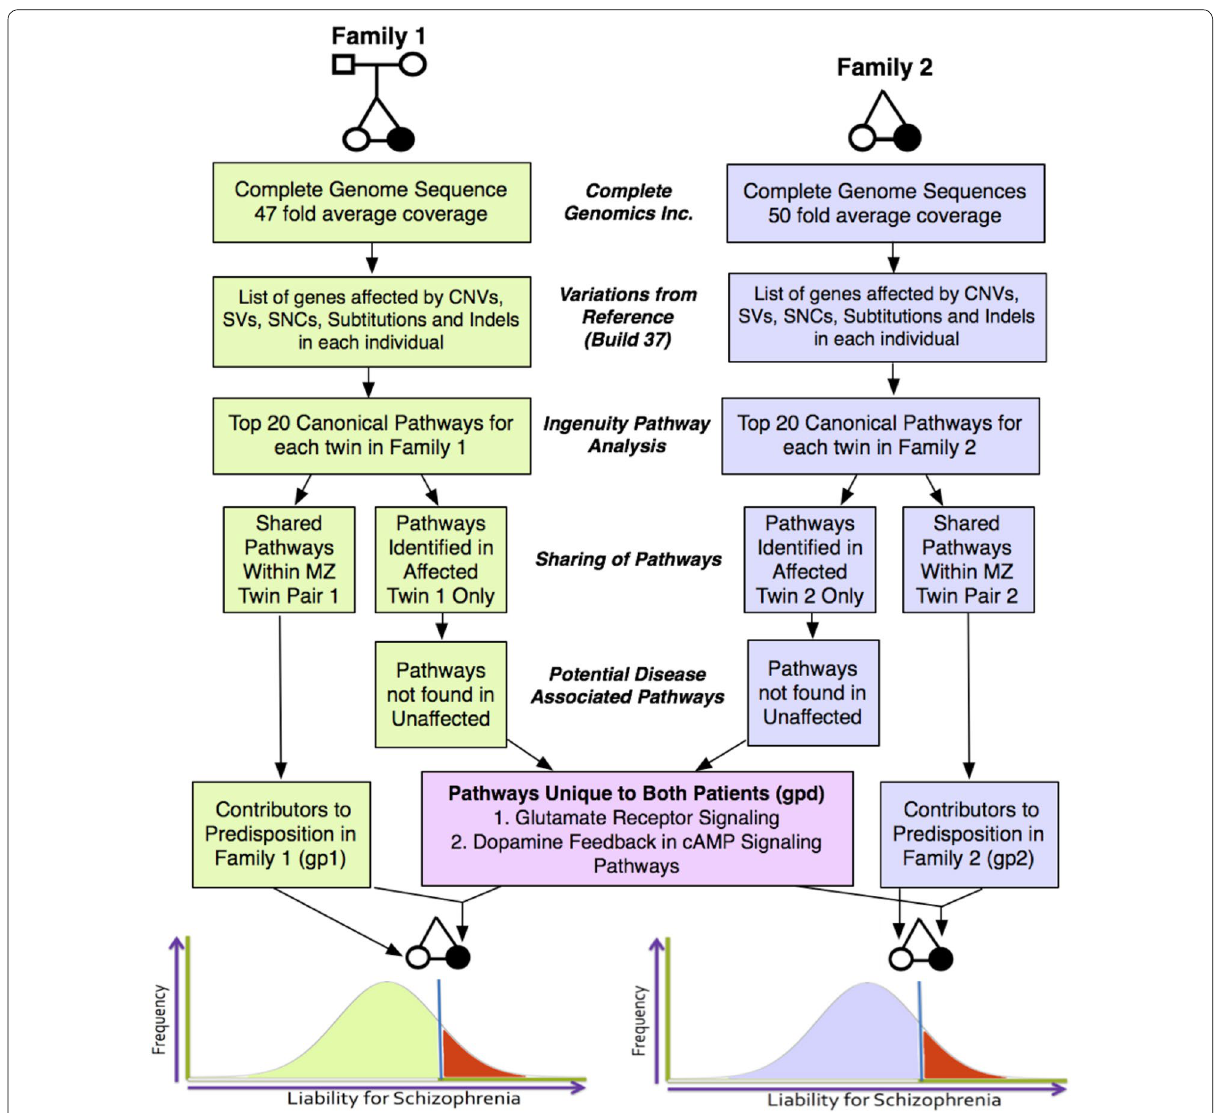
Fig. 6 Analysis of ingenuity pathway